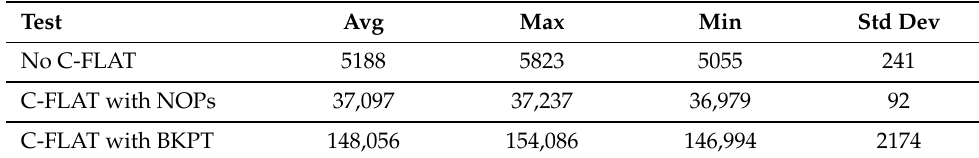
Figure 10. Measurement program for C-FLAT Linux. Table 3. Program execution times in µ